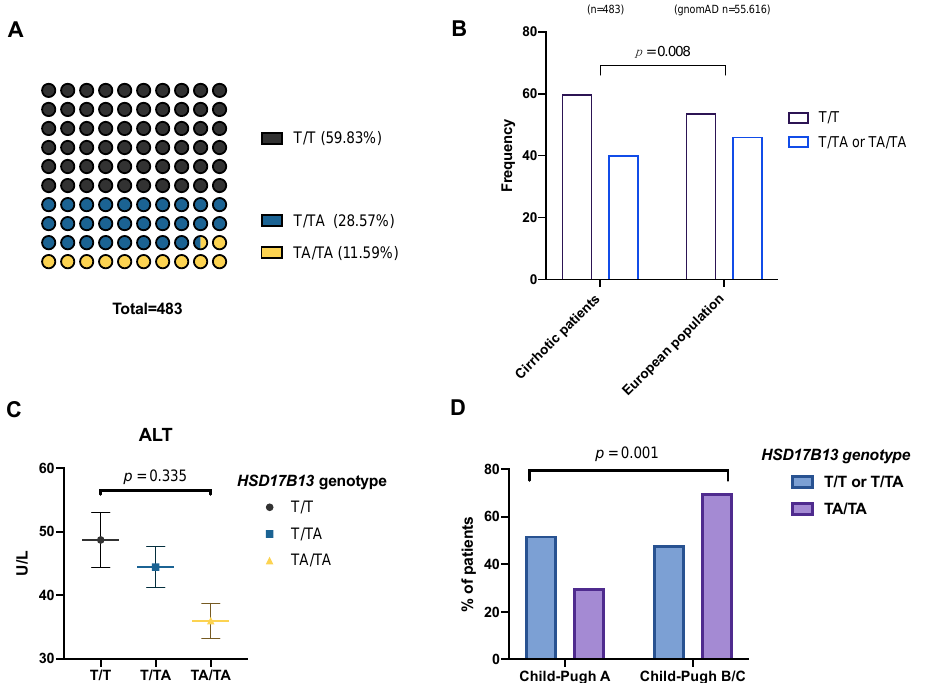
Figure 1. ( A ) Genotype frequency for rs72613567. ( B ) Comparison of minor allele frequency (MAF) across studies and in regards to liver function. ( C ) Alanine aminotransferase levels in patients with different genotypes (ANOVA). ( D ) Distribution of genotypes according to liver function measured by CTP score.